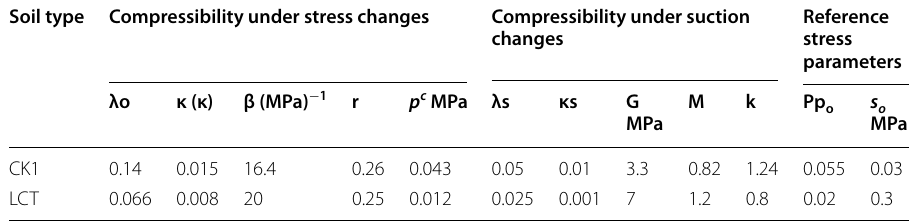
CK1 Compacted kaolin, LCT Lower Cromer till